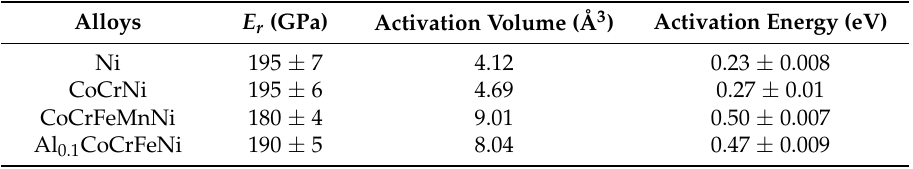
Table 1. Reduced modulus, activation volume, and activation energy of present face-centered cubic (FCC) alloys.